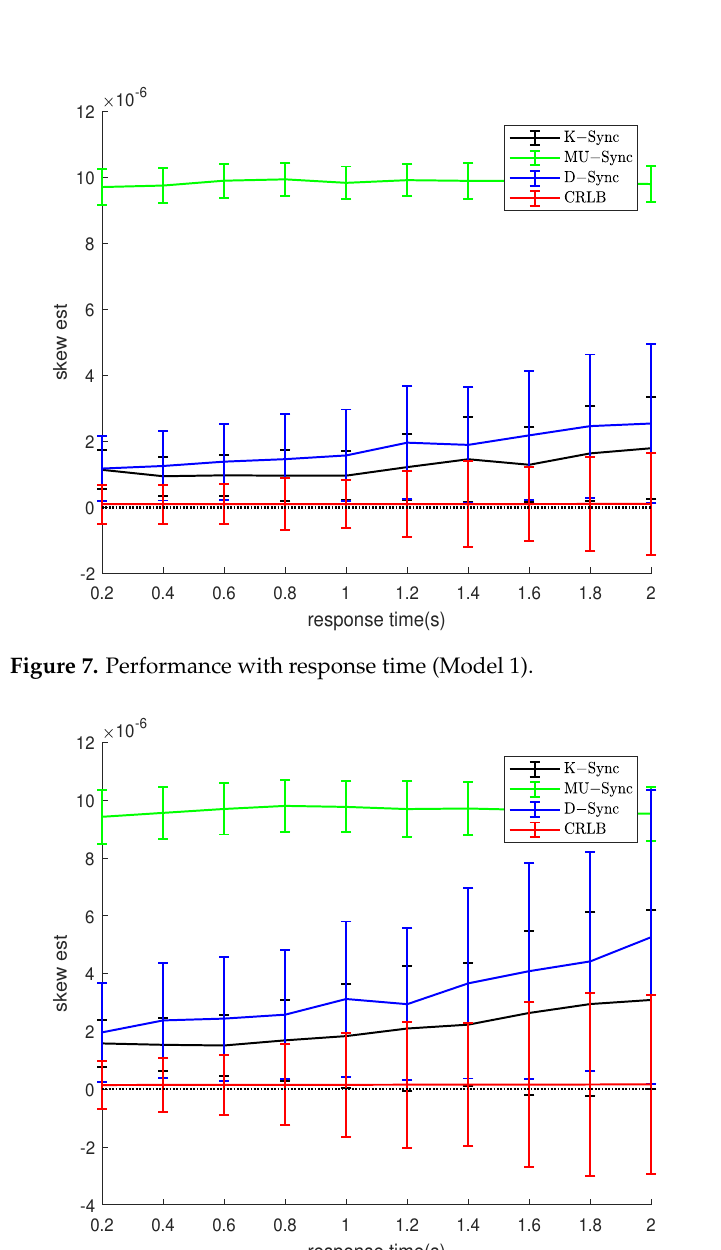
increase in message exchange interval, and the stability of clock synchronization